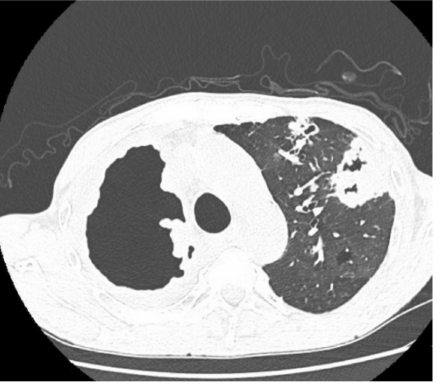
Figure 4. CT scan of the chest taken at the beginning of treatment 21 December